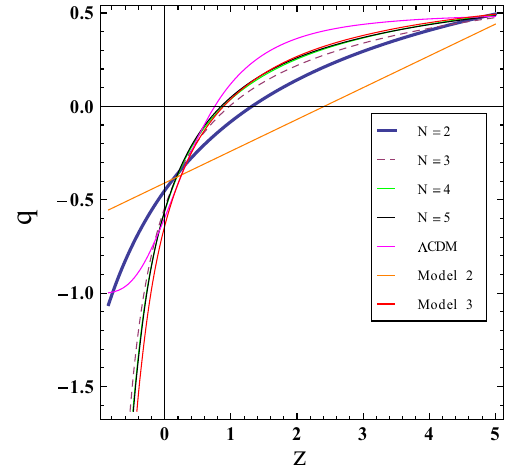
Fig. 3 Evolution of q ( z ) is shown up to z > − 1 for various models using the best-fit values of q 0 and q 1 arising from the joint analysis of SNIa + BAO/CMB dataset (see Tables 1, 2)